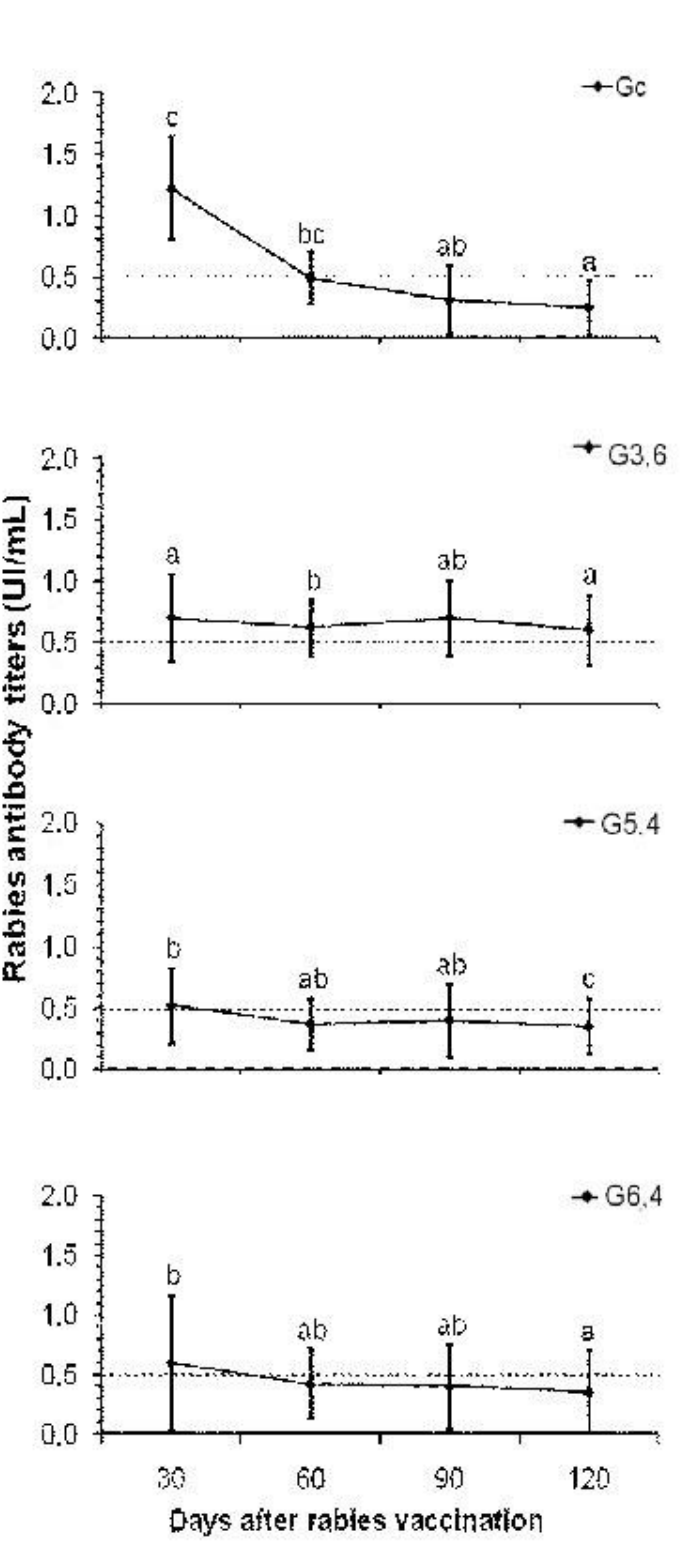
Figure 2. Median rabies antibody titers (± quartile) in Nelore cattle primo-vaccinated and supplemented with daily concentrations of 0 (Gc), 3.6 (G (G ) mg of 6.4